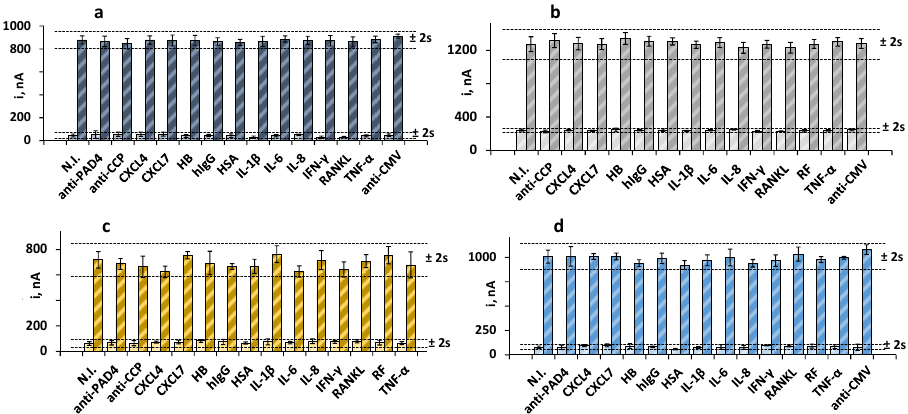
Figure 3. Amperometric measurements obtained with the quadruple bioplatform for 0 (light bars) and ( a ) 30 IU mL − 1 RF (dark blue); ( b ) 250 IU mL − 1 anti-PAD4 (dark gray); ( c ) 20 IU mL − 1 anti-MCV (dark yellow), or ( d ) 20 IU mL − 1 anti-CCP (blue) prepared in the absence and in the presence of 100 IU mL − 1 RF ( b – d ); 250 IU mL − 1 anti-PAD4 ( a , c , d ); 40 ng mL − 1 anti-MCV ( a , b , d ), 100 IU mL − 1 anti-CCP ( a – c ), and 50 ng mL − 1 CXCL4, 50 ng mL − 1 CXCL7, 5 ng mL − 1 HB, 1 mg mL − 1 hIgG, 50 pg mL − 1 HSA, 50 pg mL − 1 IL-1 β , 300 pg mL − 1 IL-6, 300 pg mL − 1 IL-8, 100 pg mL − 1 IFN- γ , 50 pg mL − 1 RANKL, 100 IU mL − 1 RF, or 200 pg mL − 1 TNF- α . Error bars are estimated as three times the standard deviation value of three